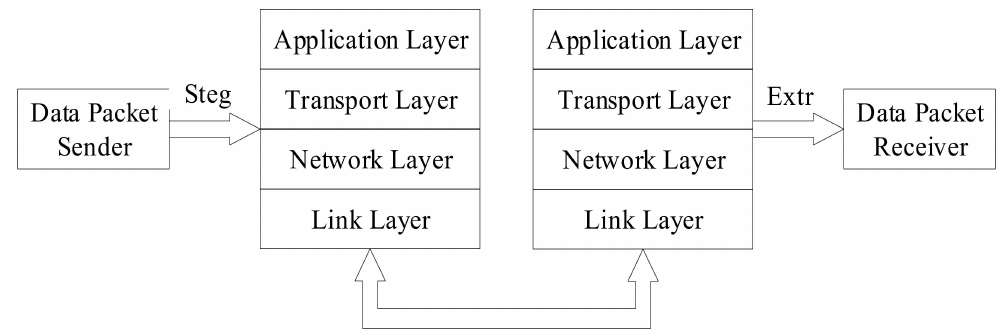
Figure 5. Model of the transmission of hidden information VoIP based on network